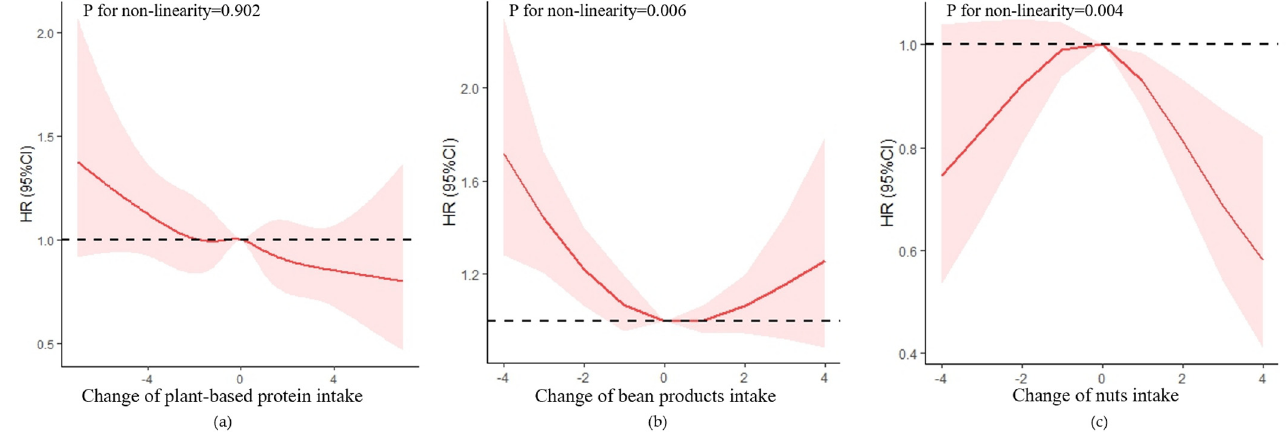
Figure 4. Association between changes in protein intake and cognitive impairment based on restricted cubic spline model after adjusted for age (continuous), gender, residence, years of schooling, marital status, economic status, living pattern, tobacco smoking, alcohol drinking, regular exercise, ADL, IADL, BMI, and chronic disease (hypertension, diabetes, heart disease, stroke or CVD, cataract, digestive system disease, arthritis, Parkinson’s disease). ( a ) Change in plant-based protein intake; ( b ) change in bean products intake; ( c ) change in nuts intake. The red lines represent the HRs, the shades of pink represent the 95% CIs, and the dotted lines represent the reference HRs of one.